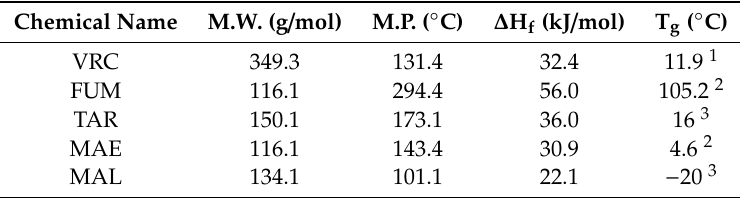
Table 1. Thermal properties of VRC and C4 diacid